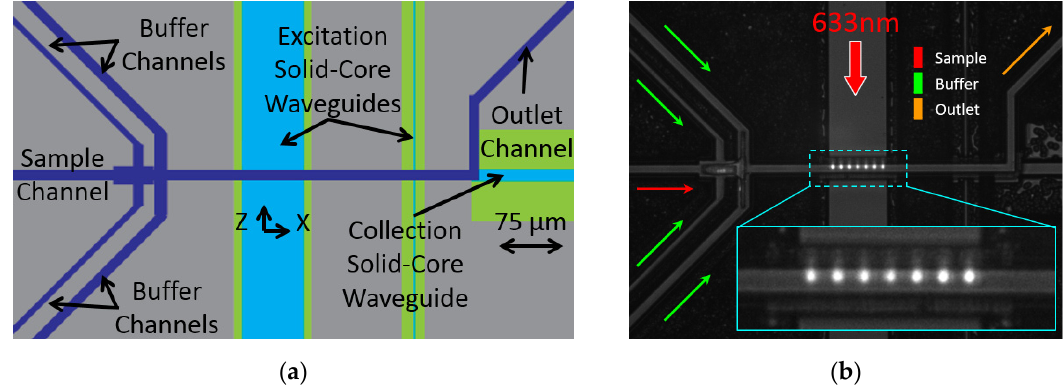
Figure 8. ( a ) Top down schematic of the center of the optofluidic chip. Fluid flows from left to right in the dark blue liquid-core channels, passing through the focusing junction before interacting with the light delivered by the light blue solid-core waveguides. ( b ) Photograph of on-chip multi-mode interference excitation waveguide (MMI) multi-spot excitation scheme using fluorescent dye and DI water.